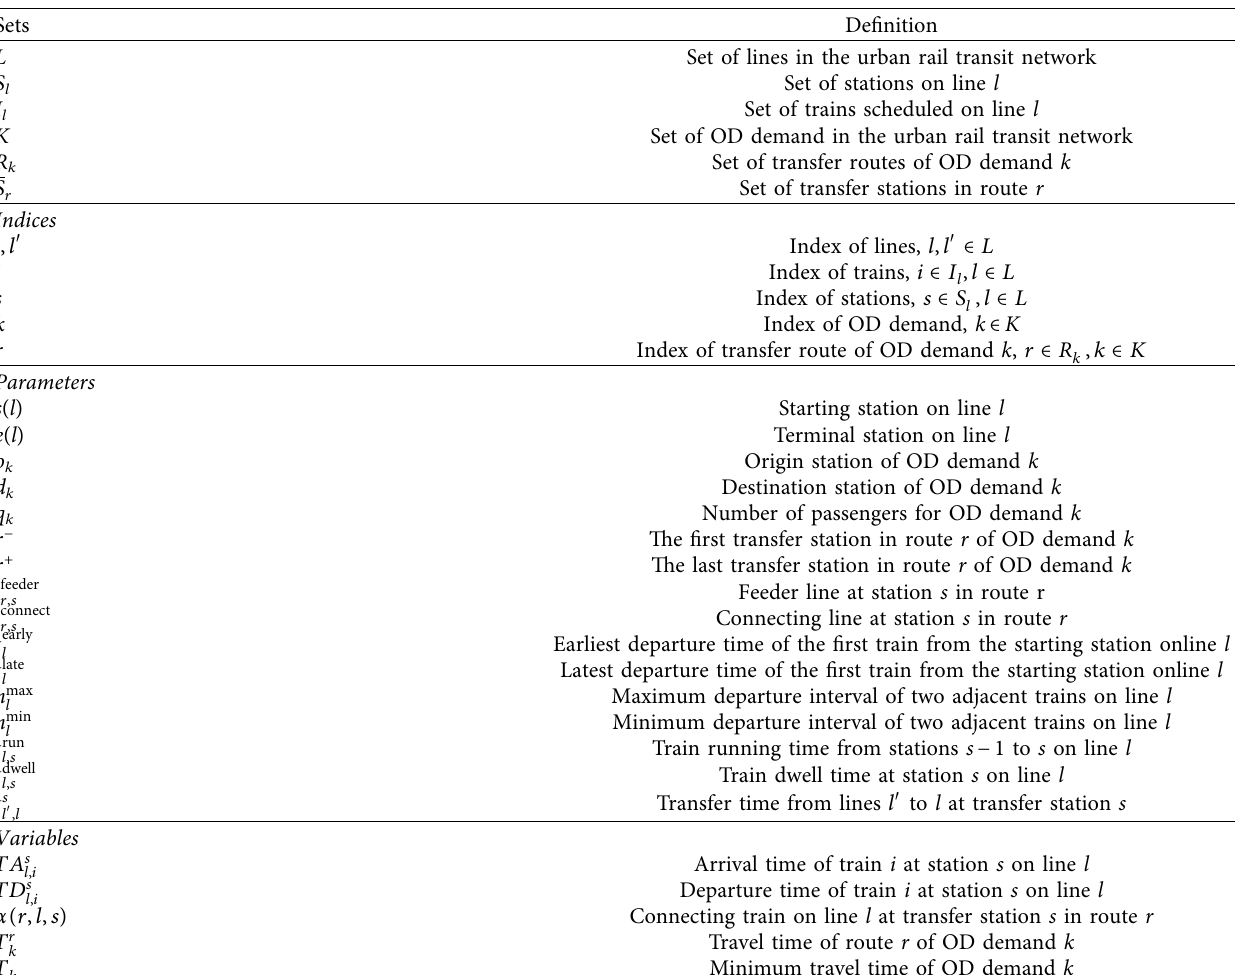
Table 2: Sets, indices, parameters, and